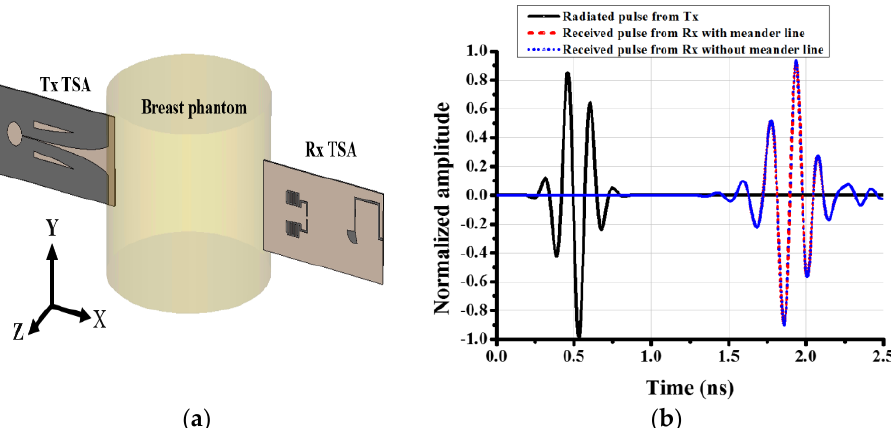
Figure 12. ( a ) Simulation configuration to verify the pulse distortion characteristic and ( b ) radiated and received pulse characteristics.